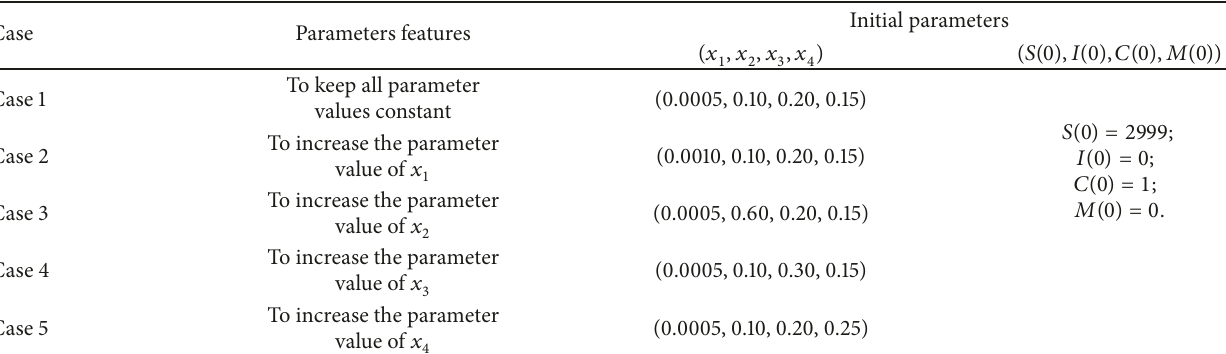
Figure 5: The evolutionary characteristics of risk contagion after increasing 𝑥 3 (Case 4). Table 1: The features of parameters in different simulation